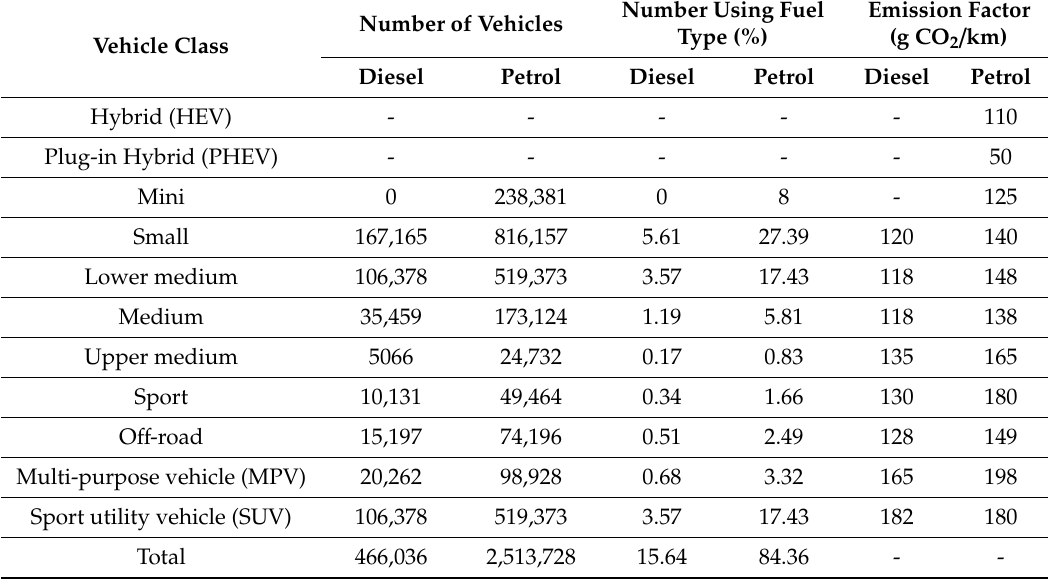
Table 1. Disaggregated profiles of motorcars in Gauteng and national average CO 2 emission factors [11,16,22]. Number Using Fuel Emission Factor Number of Vehicles Type (%) Vehicle Class